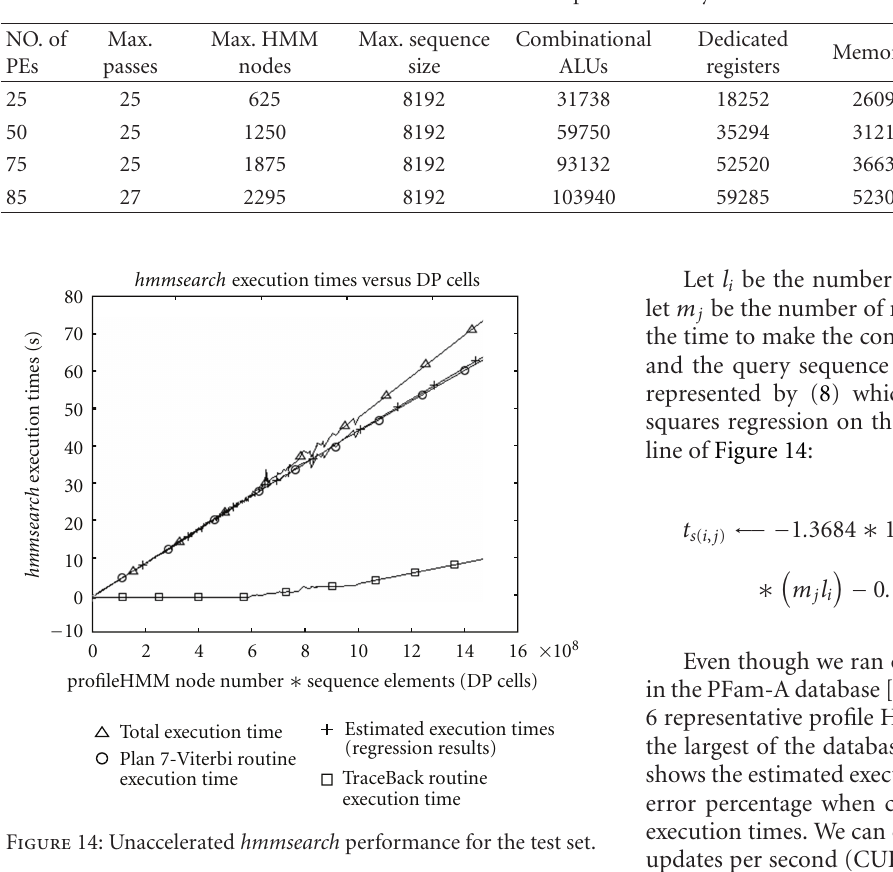
Table 3: Area and performance synthesis results.